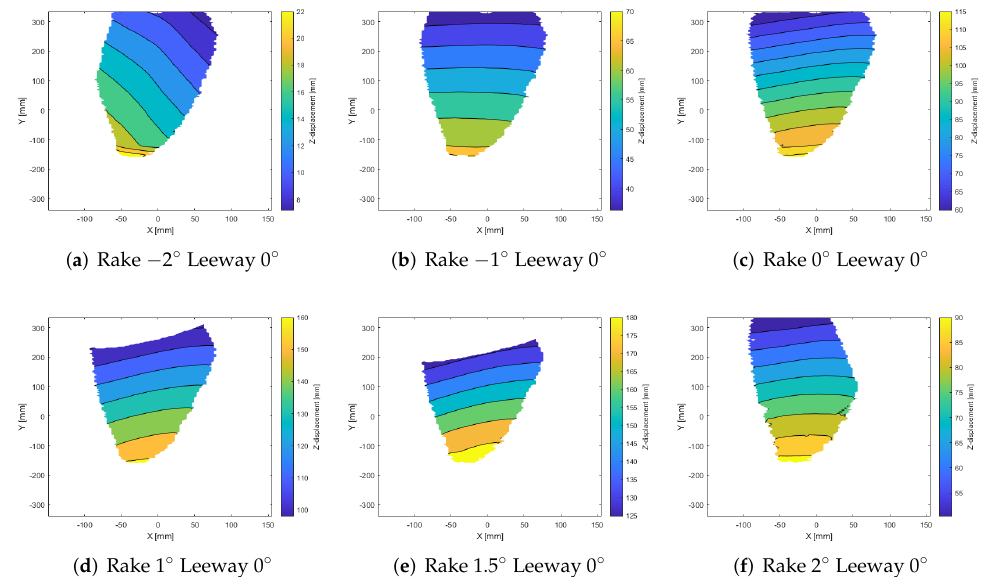
Figure 24. Change in z-deflection for a range of rake angles at a leeway of zero degrees at flow speed of 9 m/s.